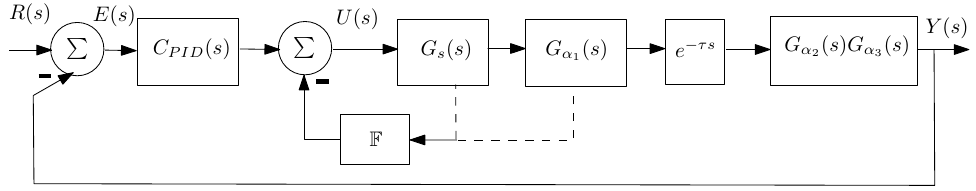
Figure 1. PID controller